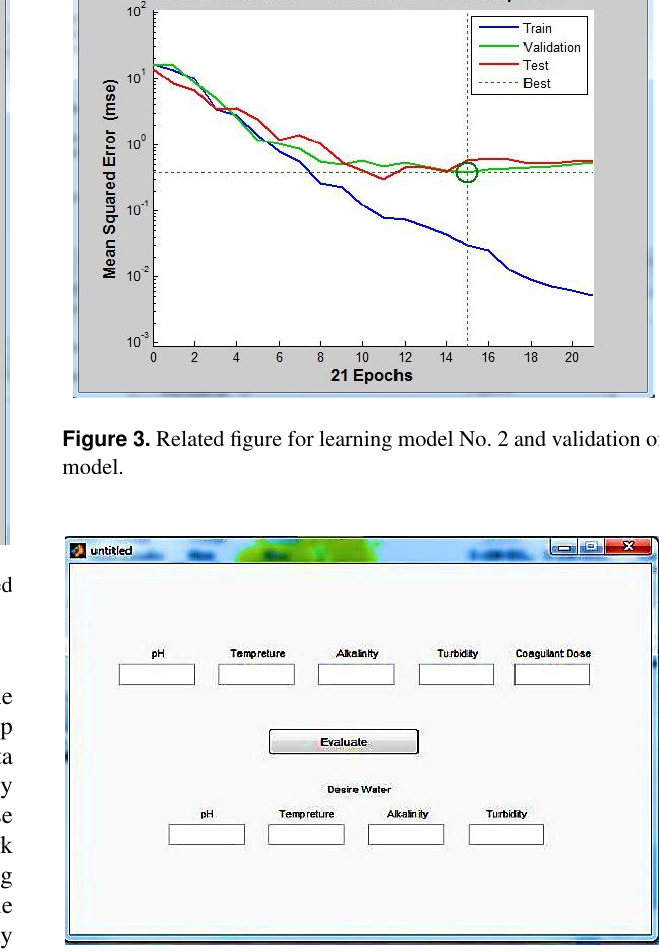
Figure 4. The graphical user interface (GUI) of the Model No.